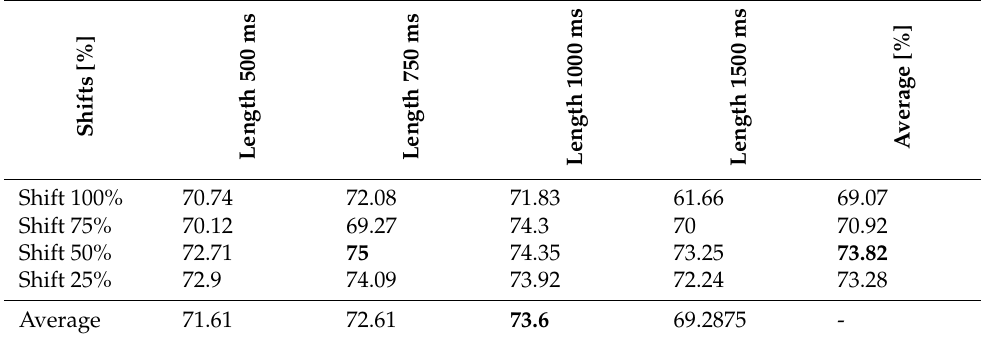
Table 1. Effect of signal lengths and shifts on accuracy. Averaged values for lengths and shifts are also given. The best options are in bold.